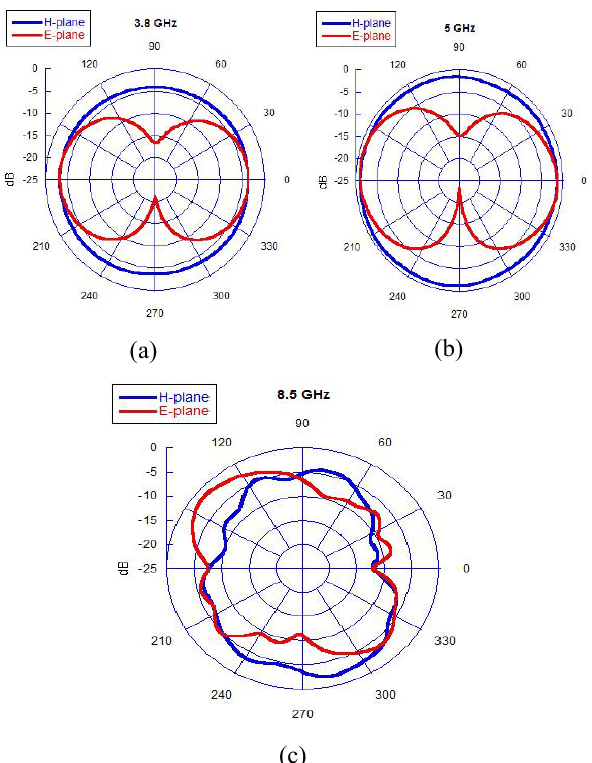
Figure 11: Simulated radiation patterns of the proposed antenna at (a) 3.8 GHz, (b) 5 GHz and (c) 8.5